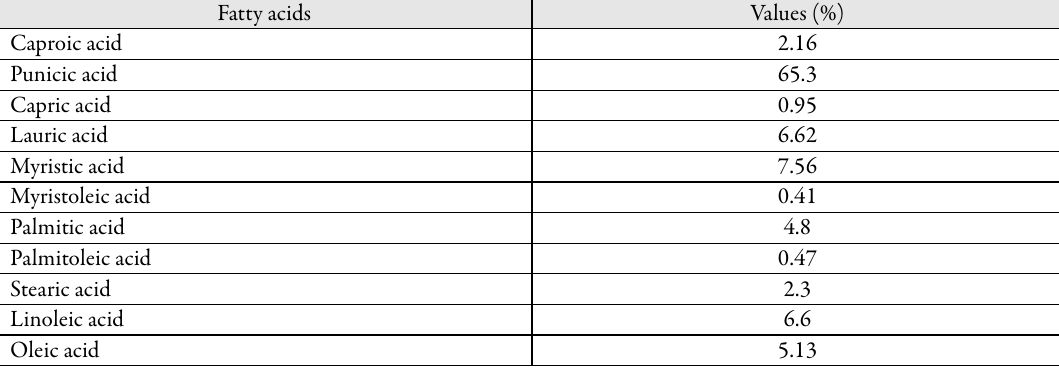
Table 4. Fatty acids found in pomegranate seeds (Khan et al ., 2017) Fatty acids Caproic acid